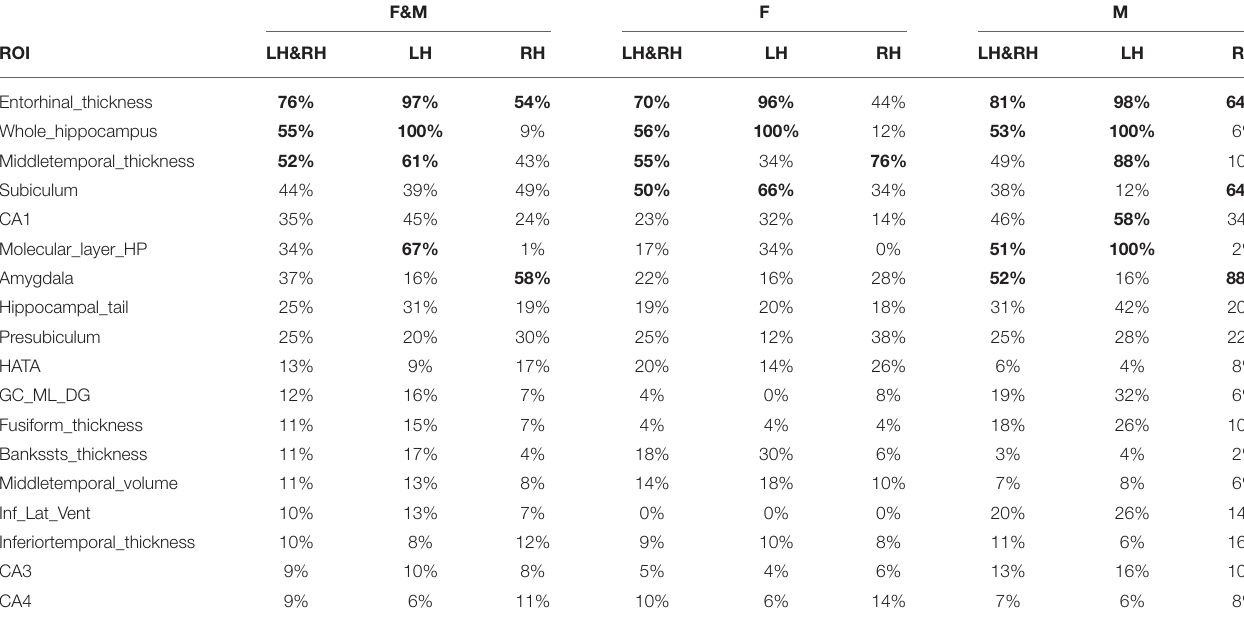
TABLE 2 | ROIs selected over all folds of all cross-validation trials for both